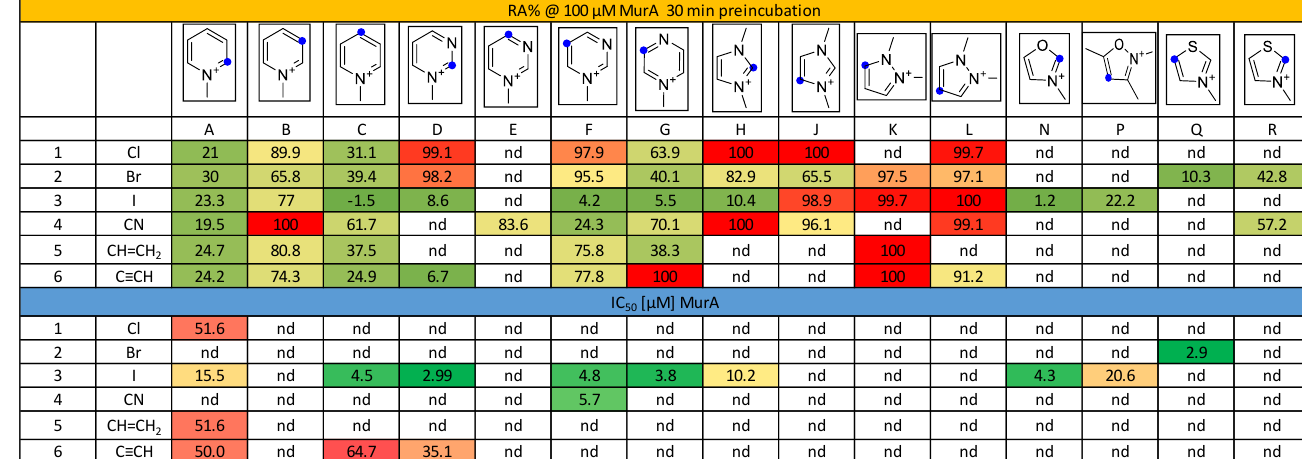
Figure 1. Inhibitory activity of methylated electrophilic heterocycles against MurA represented in residual activity (RA %) after 30 min preincubation and IC 50 values (μM). Blue dots indicate the position of the warhead. Coloring is in line with the activity, from red (low) through yellow (moderate) to green (high). nd stands for “not determined”.